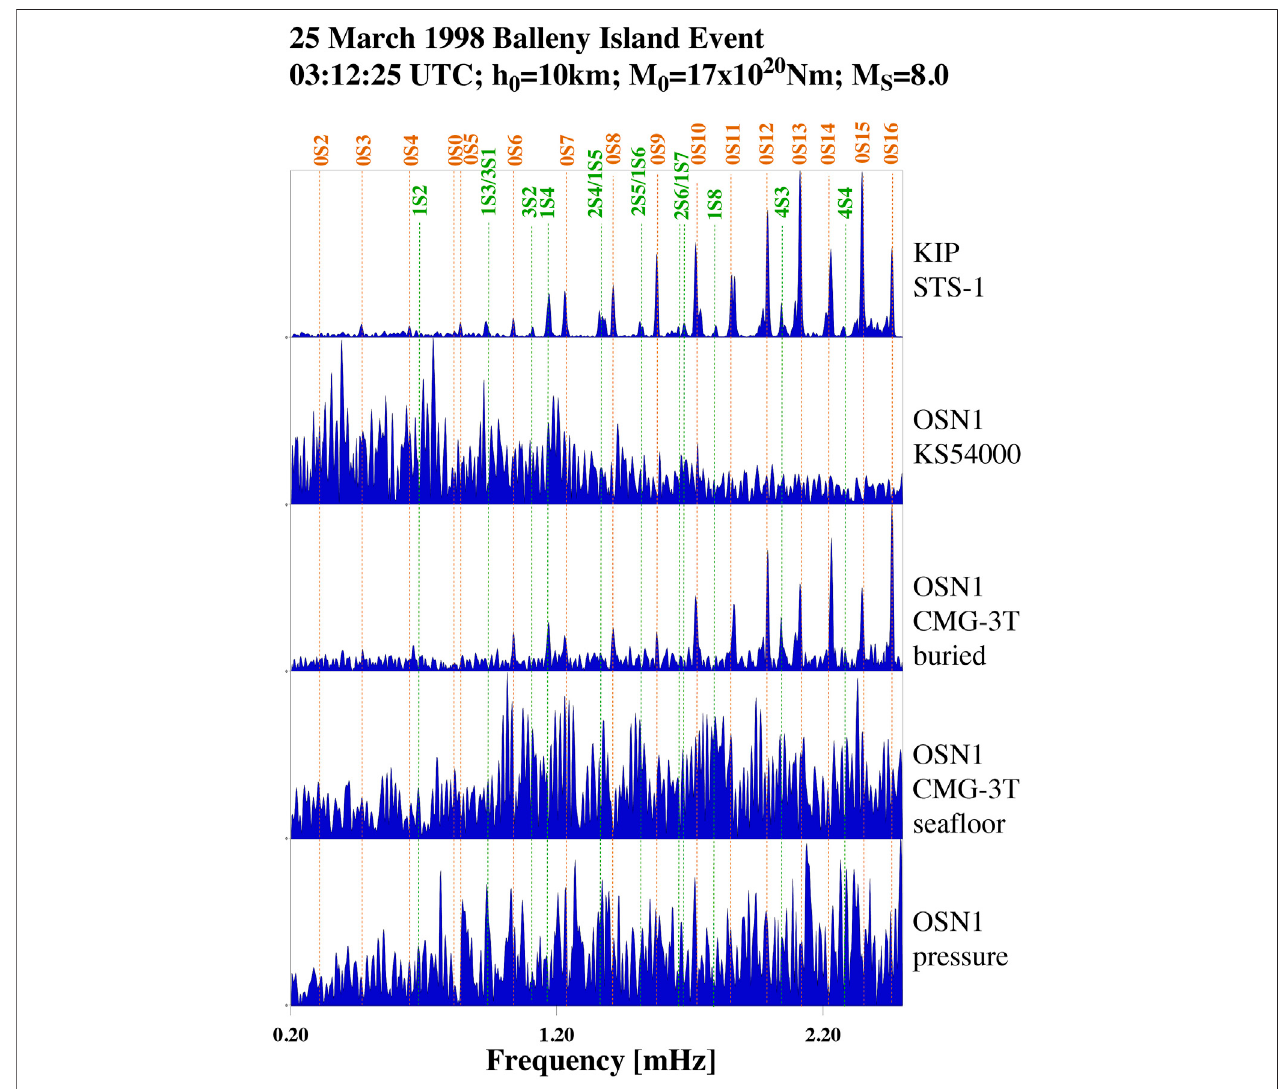
FIGURE 3 | Raw vertical-component spectra for the March 25, 1998 Balleny Island earthquake of 50-hour long segments, starting 1.5 h after the source time. Hanning tapers are applied. Shown are spectra for GSN station KIP and the ocean bottom sensors deployed at OSN1( Figure 1 ). Comments below the station name denote the seismic sensor. At OSN1, pressure was recorded on a Cox-Webb differential pressure gauge (DPG Cox et al., 1984). In the frequency range shown here, corrections for respective instrument responses ( Figure 2 ) change the relative shape of the spectra only marginally, but modes and background noise at frequencies below 1 mHz would be enhanced. The spectra are self-normalized for optimal display. Orange lines mark fundamental mode frequencies for model PREM(Dziewonski and Anderson, 1981), while green lines mark overtones.